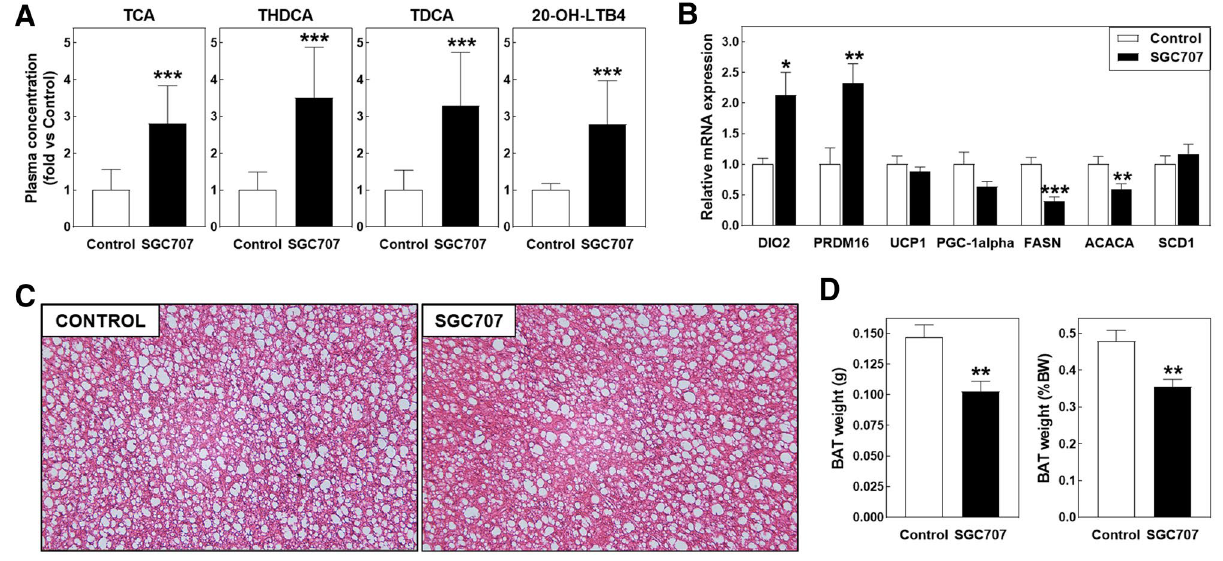
Figure 5. ( A ) Plasma concentrations of the bile acid species TCA, THDCA, and TDCA and 20-hydroxy- leukotriene B4 (20-OH-LTB4) and brown adipose tissue gene expression levels ( B ) and weights ( D ) in Western- type diet-fed male LDL receptor knockout mice treated with the PRMT3 inhibitor SGC707 or the solvent control. Values in the graphs represent the means + SEM of 5 plasma pools (panel A) or 11 mice per group (panels B and D). * P < 0.05, ** P < 0.01, *** P < 0.001 versus control. ( D ) Representative images of hematoxylin/ eosin-stained brown adipose tissue sections (magnification: